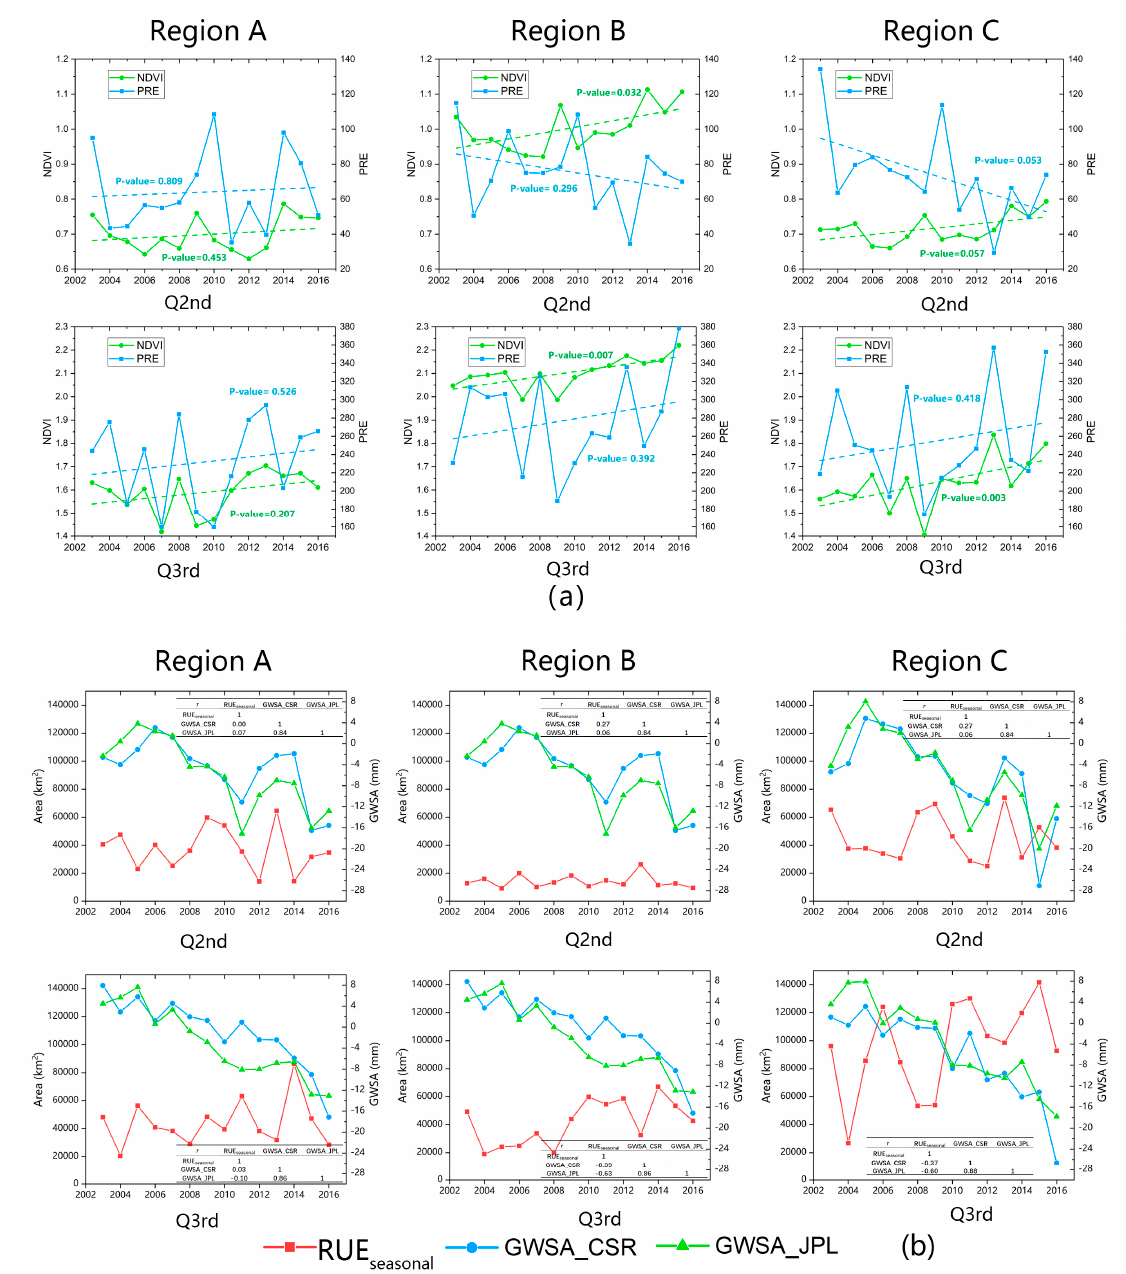
Figure 8. ( a ) Changes (NDVI and precipitation) of time series of Q2nd and Q3rd in different regions (Region A is Xilin Gol; Region B and Region C are eastern and central-western part of the study area, respectively). The green and blue dashed lines represent the liner trends of NDVI and precipitation, respectively. ( b ) Changes ( RUE seasonal and GWSA) of time series of Q2nd and Q3rd in different regions. The tables in the figure show the correlation coefficient between 𝑅𝑈𝐸 (cid:3046)(cid:3032)(cid:3028)(cid:3046)(cid:3042)(cid:3041)(cid:3028)(cid:3039) and GWSA (CSR and JPL).